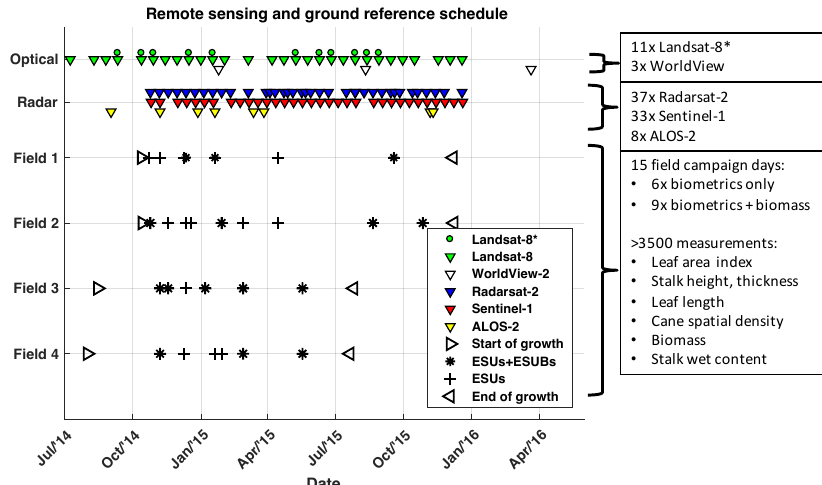
Figure 6. Temporal distribution of remote sensing images and ground-reference measurement dates. (Right box) summary of acquisitions, including number of image acquisitions per sensor, counted over growth duration. Landsat-8* symbols, LS8 acquisitions without cloud obstruction for all